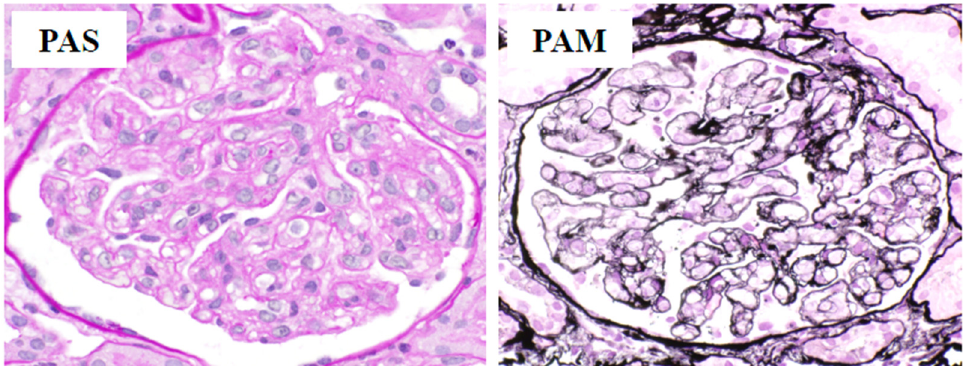
Figure 3. Kidney lesions in our patient. Periodic acid–Schiff and periodic acid methenamine silver staining shows prominent swelling and increased glomerular endothelial cells (×400).